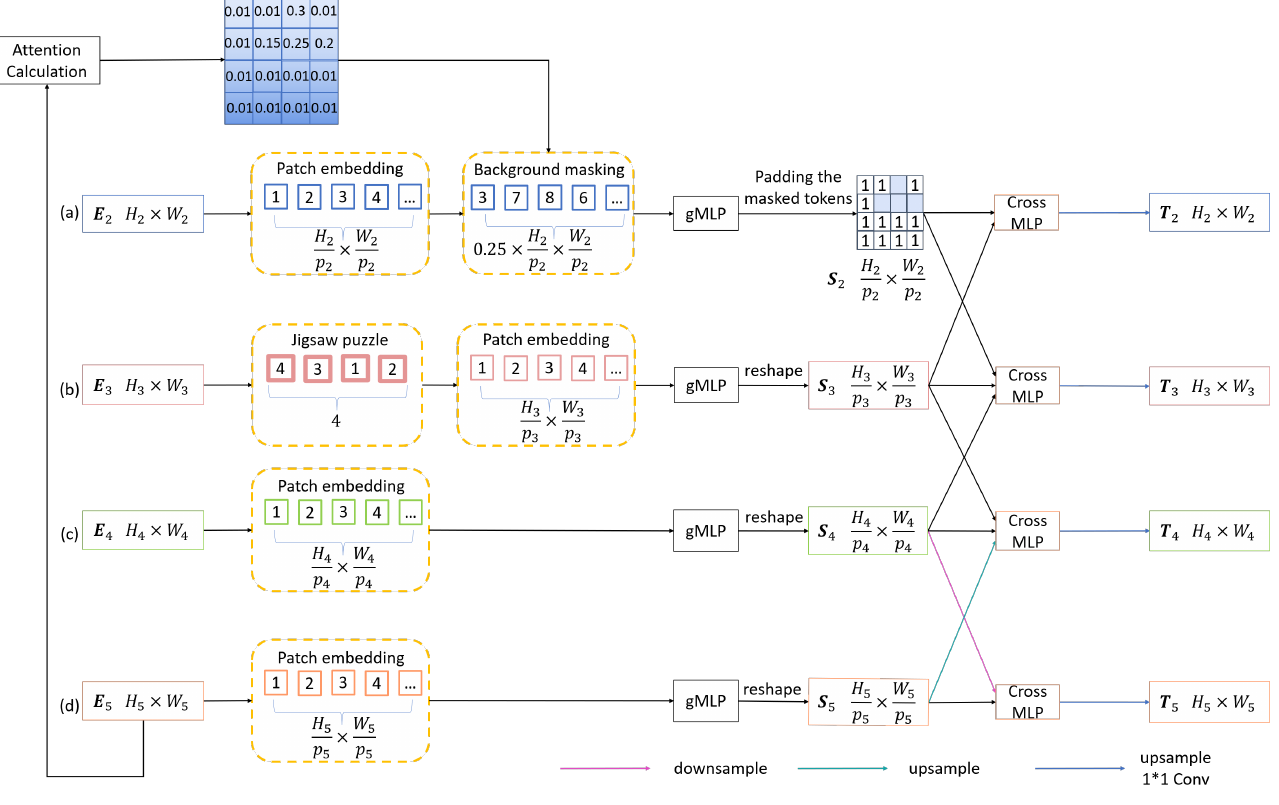
Figure 4. The self-supervised block. H i , W i , p i are the height, width and patch size of the feature map E i ,